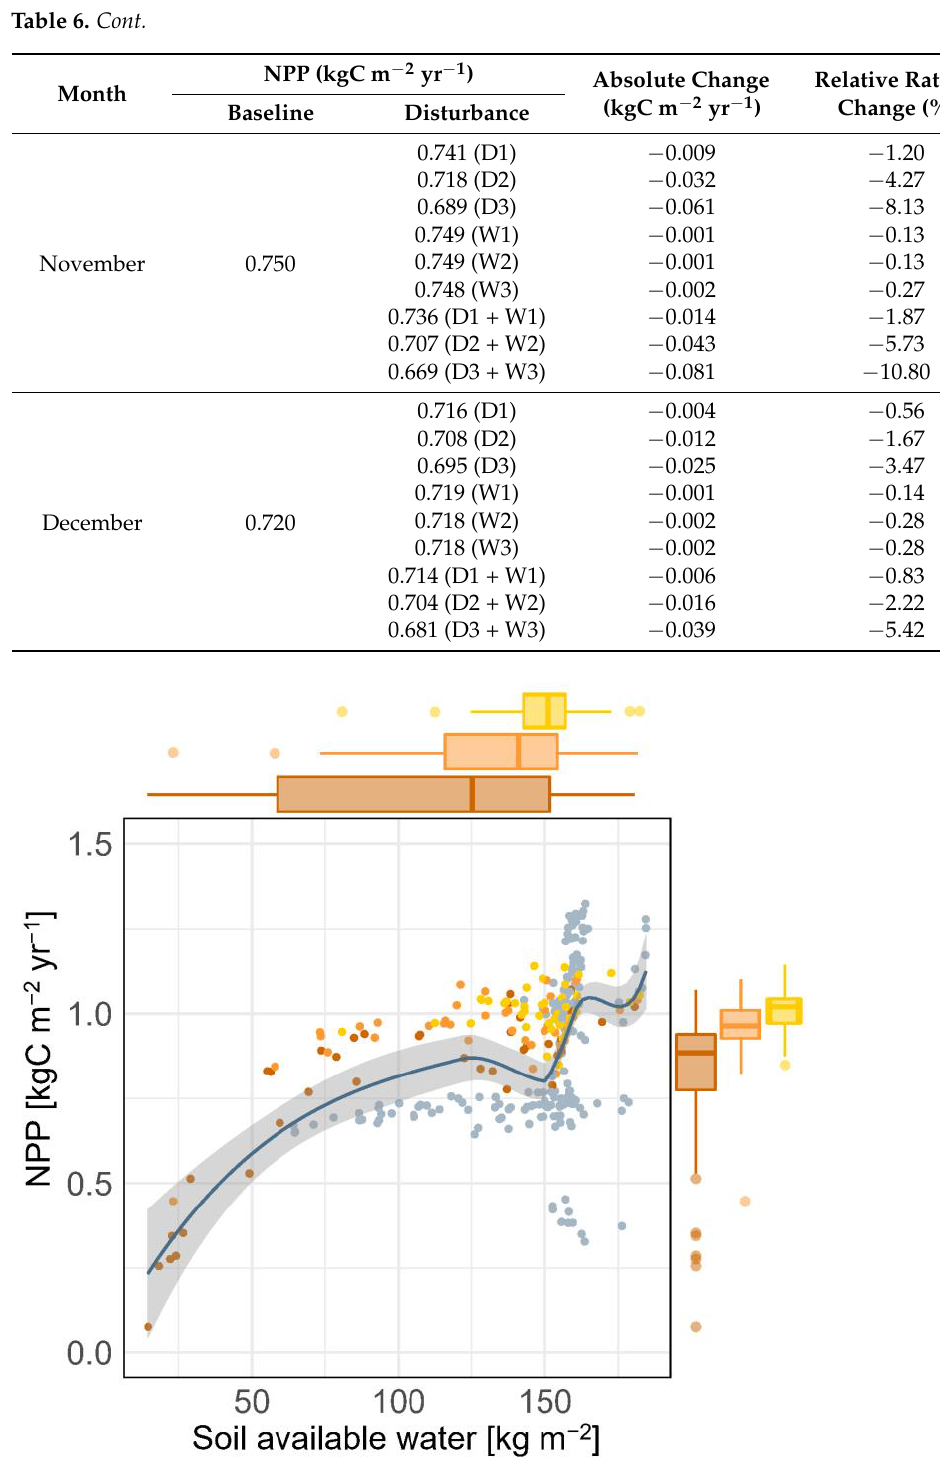
Figure 4. Relationships between soil available water [kg m − 2 ] and NPP [kgC m − 2 yr − 1 ]. The grey points represent the NPP under the baseline scenario (B0) and before (January~May) and after (November~December, except for October) the drought scenarios. The light, moderate, and dark yellow points represent the NPP during (July~September) and after (only October) a mild (D1), moderate (D2), and severe (D3) drought scenario, respectively. The boxplots on the top and right indicate the distributions of soil available water and NPP under three drought scenarios (D1, D2, and D3),